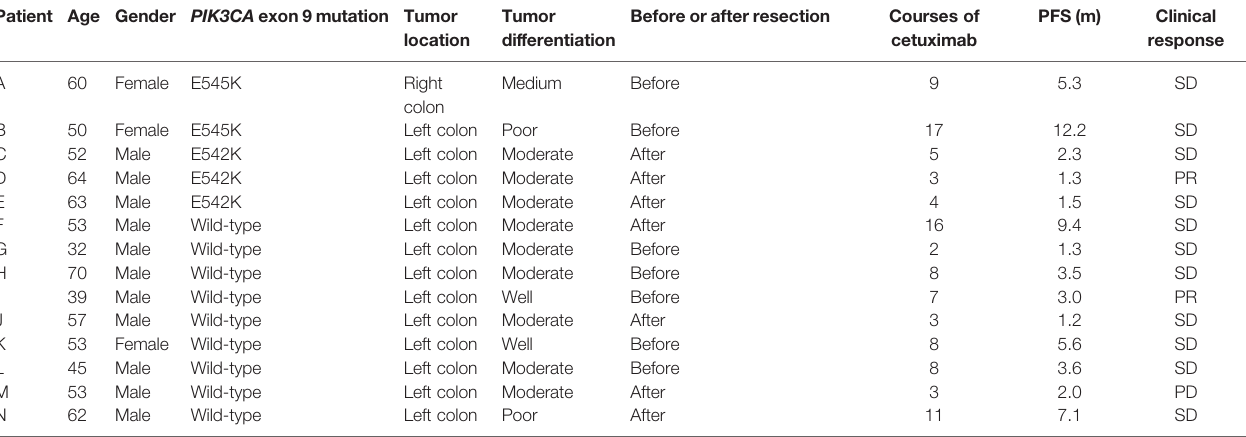
TABLE 5 | Cetuximab response in 14 wild-type KRAS , NRAS and BRAF mCRC patients with/without PIK3CA exon 9 mutations. Patient Age Gender PIK3CA exon 9 mutation Tumor